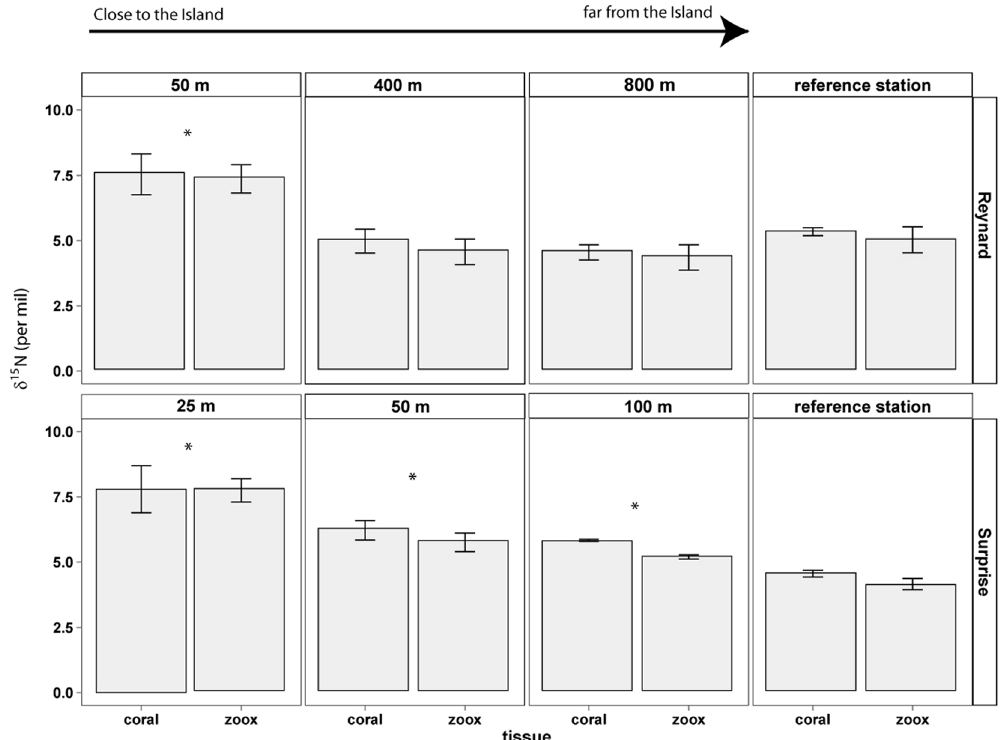
Figure 4. δ 15 N values from Reynard islet and Surprise islets in coral tissues and zooxanthellae. Stars denote significantly higher values compared to the reference station (0.05 significance level, statistical results for coral and zooxanthellae are the same). Note that the distances of sampled sites from the shore are different between islets.